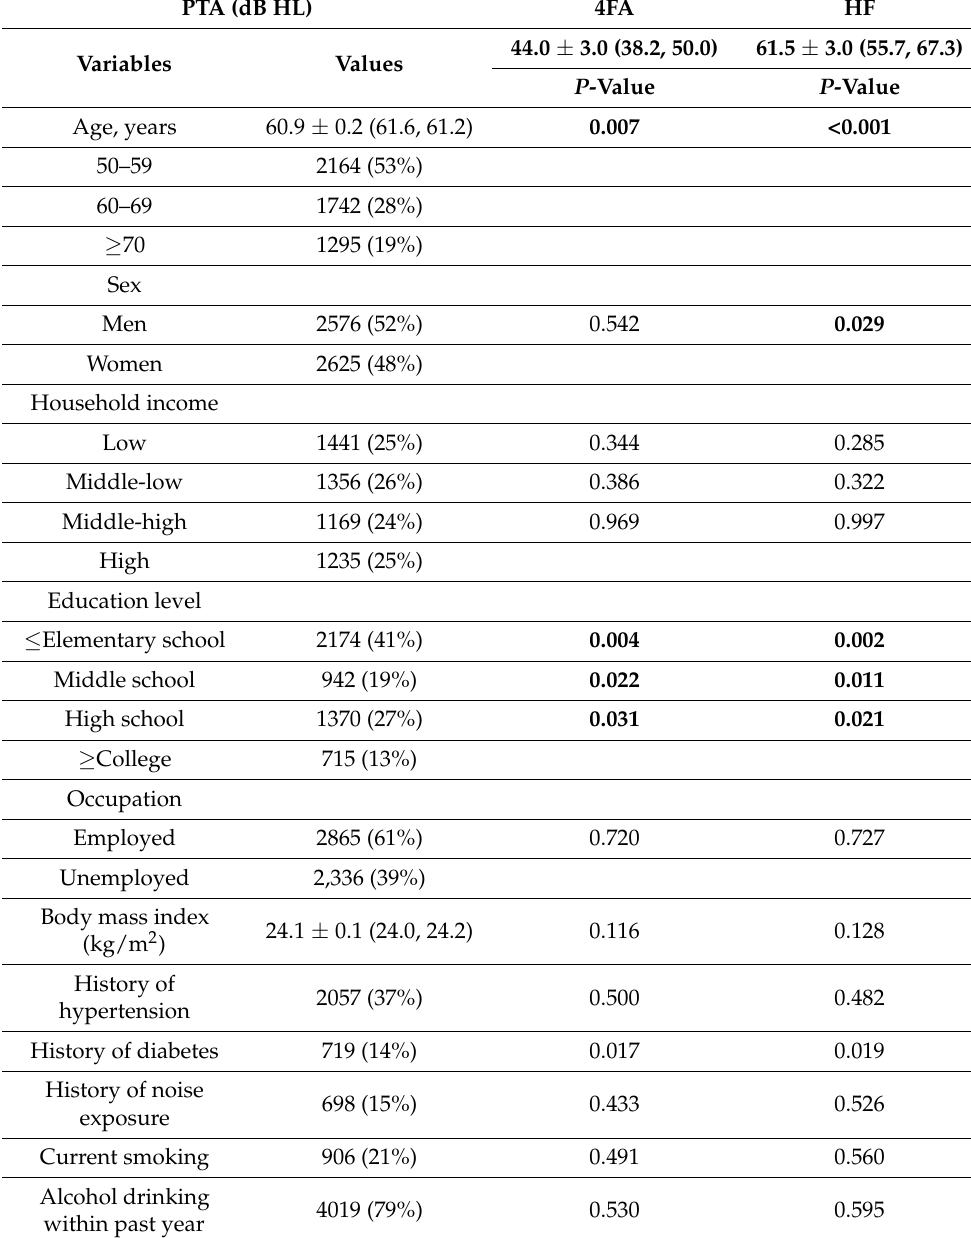
Table 1. Characteristics of participants and factors associated with hearing loss ( N =